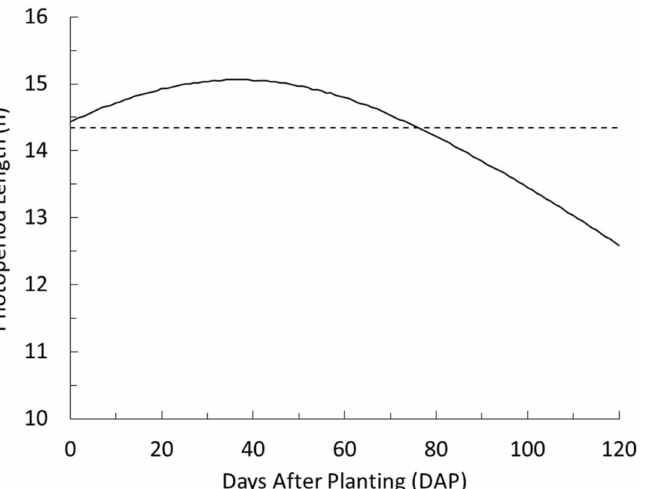
Figure 5. Photoperiod length in relation to days after planting (DAP), where day zero represents 15 May for West Lafayette, IN, USA (40.4237 ◦ N, 86.9212 ◦ W). Dashed line (y = 14.34) represents the average day length for the simulated photoperiod (solid line).